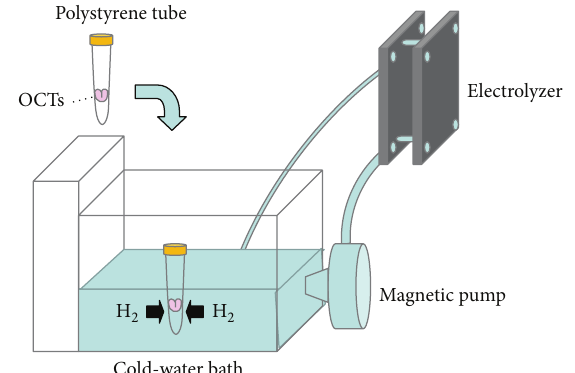
Figure 1: Hydrogen electrolyzer system used to introduce hydrogen into the preservation solution used for long-term cold storage of osteochondral tissue (OCT). The MiZ hydrogen electrolyzer system consists of an electrolyzer and a water bath connected to a refrig- eration system. OCT in preservation solution within a hydrogen- permeable polystyrene tube is immersed in the cold-water bath for the introduction of